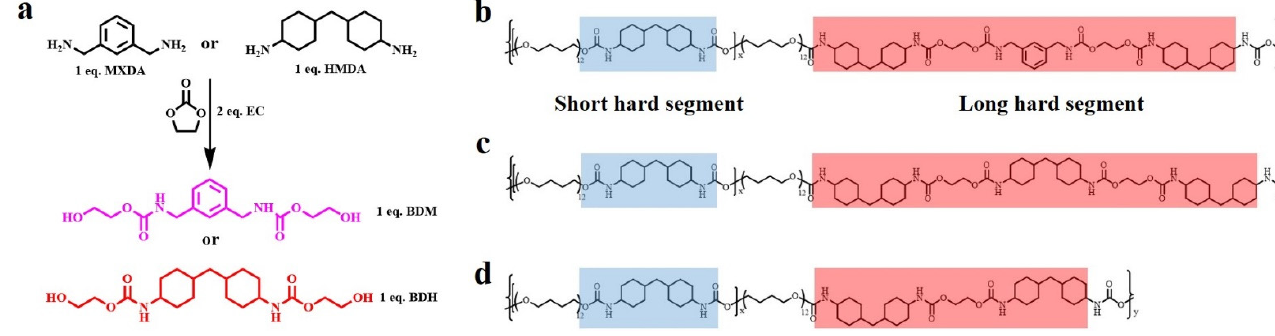
Figure 1. ( a ) Synthetic routes of BDM and BDH; ( b ) Molecular structure of BDM-1.7 elastomers em- bedded with short and long hard segments; ( c ) Molecular structure of BDH-1.7 elastomers embedded with short and long hard segments; ( d ) Molecular structure of EG-1.7 elastomers embedded with short and long hard segments.